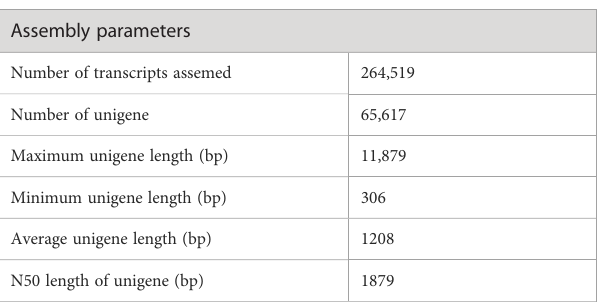
TABLE 2 Summary of the P. huashanica transcriptome assembly.